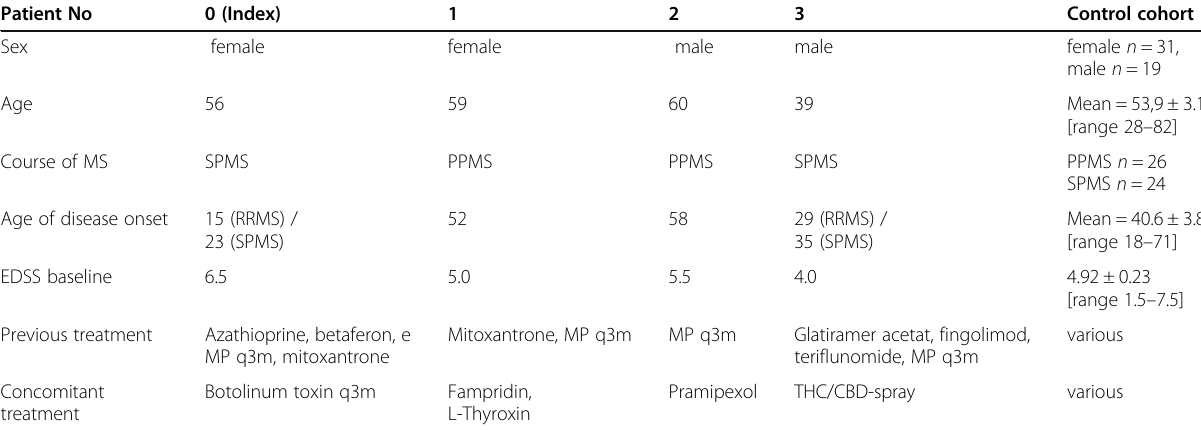
Table 1 Clinical characteristics of patients Patient No 0 (Index) 1 2